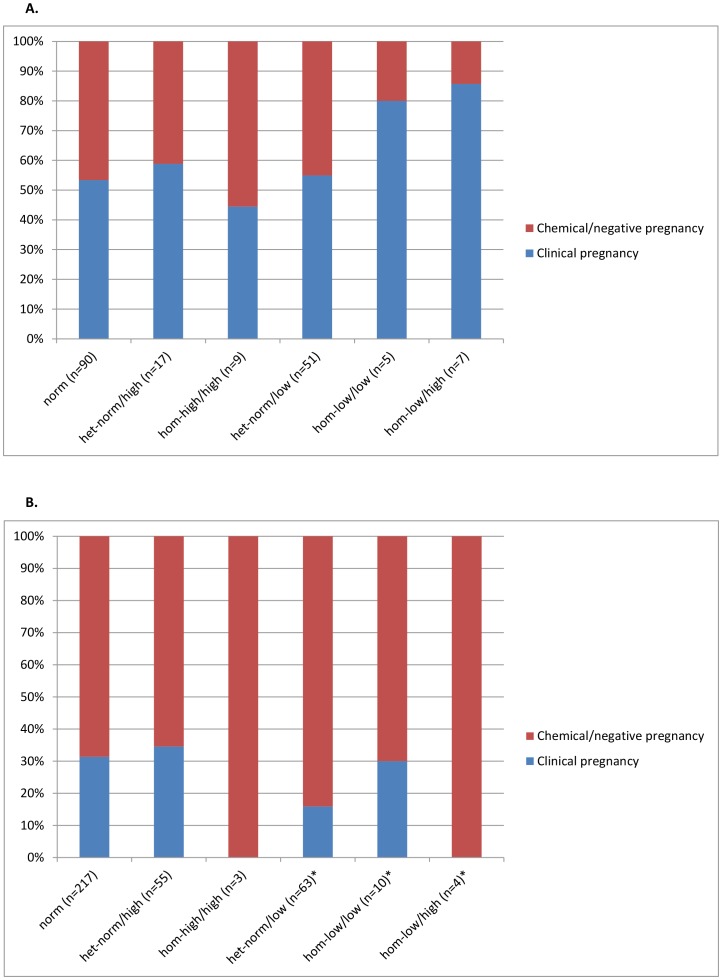
The distribution of clinical pregnancies based on FMR1 sub-genotype of Clinical pregnancy rates in A oocyte donors and B middle-aged infertility patients.Oocyte recipient pregnancy rates were not associated with donor FMR1. Using a logistic regression model in middle-aged infertility patients, OR of clinical pregnancy vs. chemical or no pregnancy was 2.244 in absence of a low FMR1 allele vs. presence of low alleles (P = 0.0015), suggesting 1.244-times odds of clinical IVF pregnancy in absence of a low FMR1 allele.